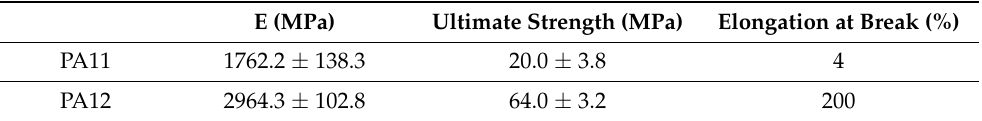
Figure 4. Stress–strain curves of PA11 and PA12 upon tensile test. Table 1. Tensile properties of PA11 and